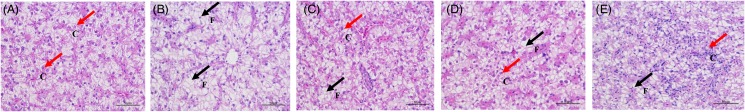
Paraffin section of liver in juvenile black seabream (Acanthopagrus schlegelii). The liver section was stained with haematoxylin and eosin to enhance the contrast (400×). (A) Paraffin section of liver in the control group; (B) paraffin section of liver in the high-fat diet (HFD) group; (C) paraffin section of liver in the HFD + choline (3 g/kg) group; (D) paraffin section of liver in the HFD + choline (6 g/kg) group; (E) paraffin section of liver in the HFD + choline (12 g/kg) group. C, cell nucleus; F, fat drop.